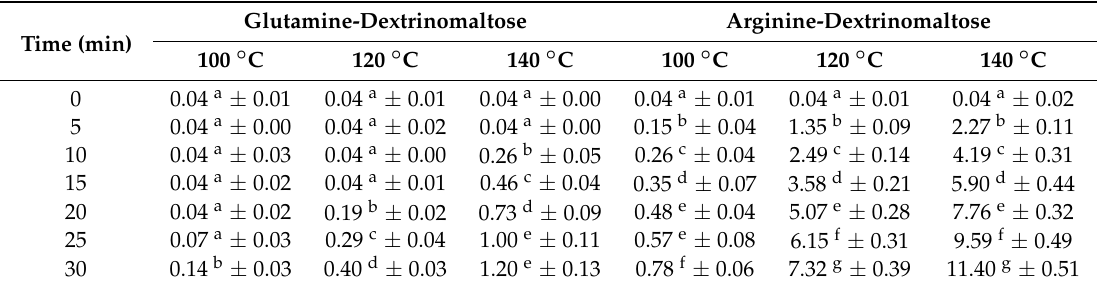
Table 2. 5-Hydroximethylfurfural (HMF) content (mg · L − 1 ). Values are means ± SD, n = 3; Different letters within a column indicate significant differences between groups ( p <